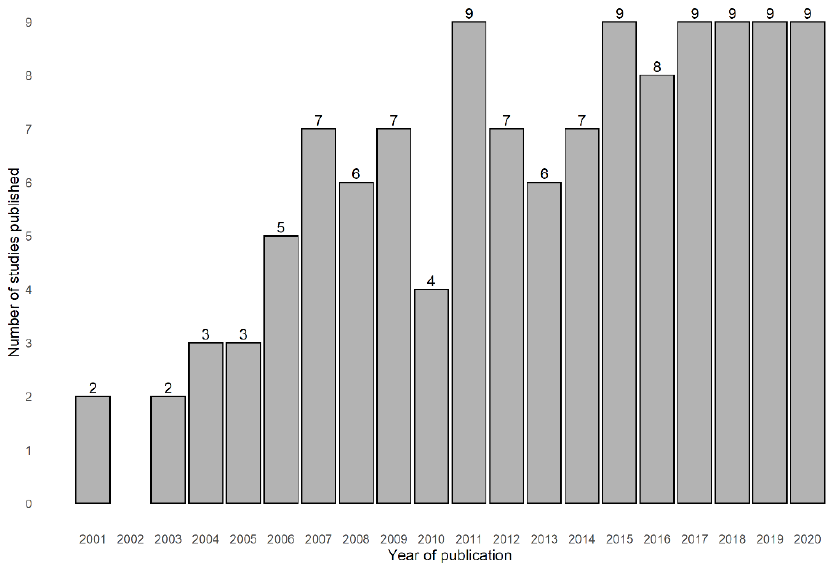
Figure 2. Distribution of the number of studies that assessed the association between healthy ageing and neighbourhood socioeconomic processes and dynamics by year of publication (2001 – 2020). The year 2021 was not included since the period was not a complete year.